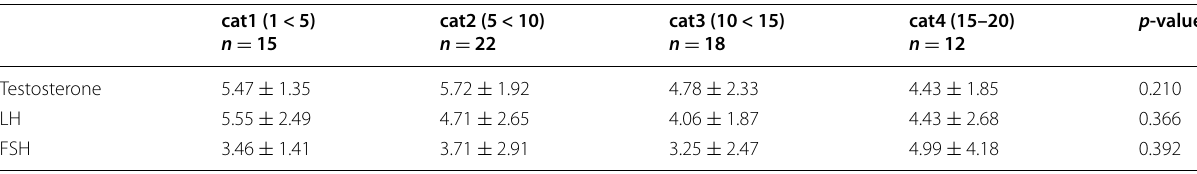
P ‑value of ANOVA test < 0.05* is statistically significant. N m IU/ml)